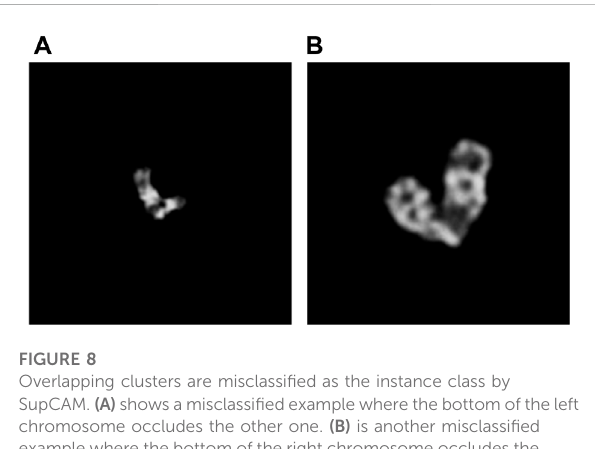
FIGURE 8 Overlapping clusters are misclassi fi ed as the instance class by SupCAM. (A) shows amisclassi fi edexample where the bottom of theleft chromosome occludes the other one. (B) is another misclassi fi ed example where the bottom of the right chromosome occludes the bottom of the left